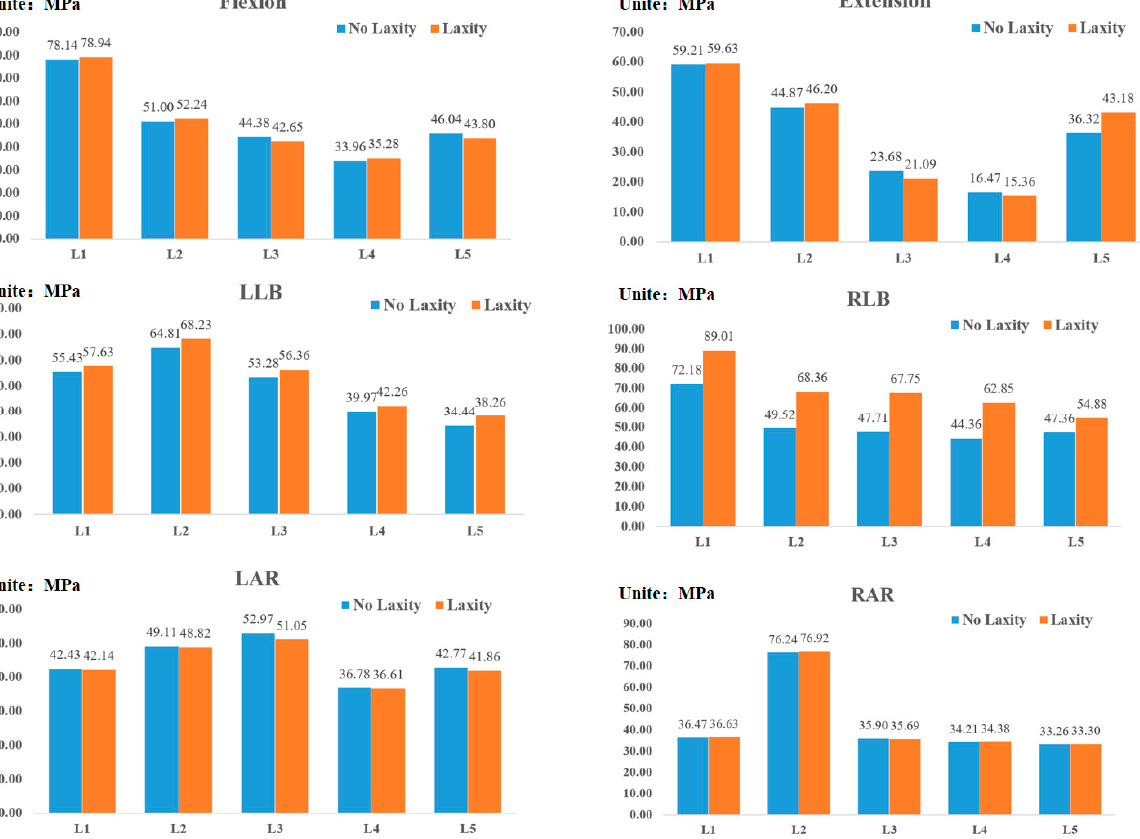
Figure 3. The maximum stress value of the vertebral body under each load.